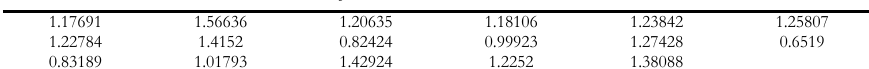
Simulated data from Weibull model with